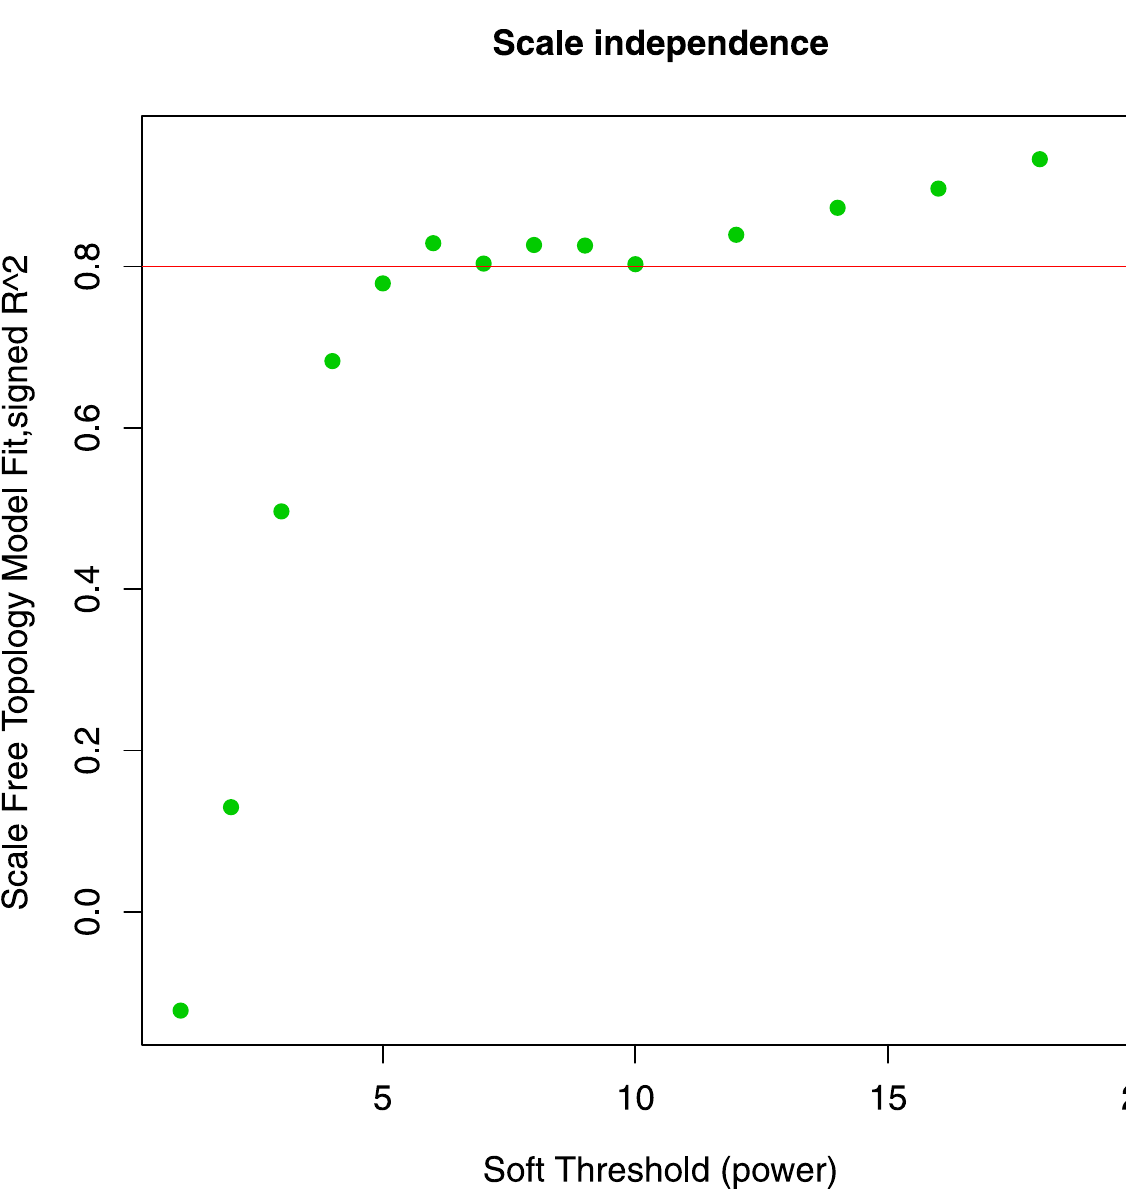
Fig 10. Scale free topology fitting index for different soft thresholds. β value equal to 6 was the smallest threshold that presented R 2 greater than 0.8.